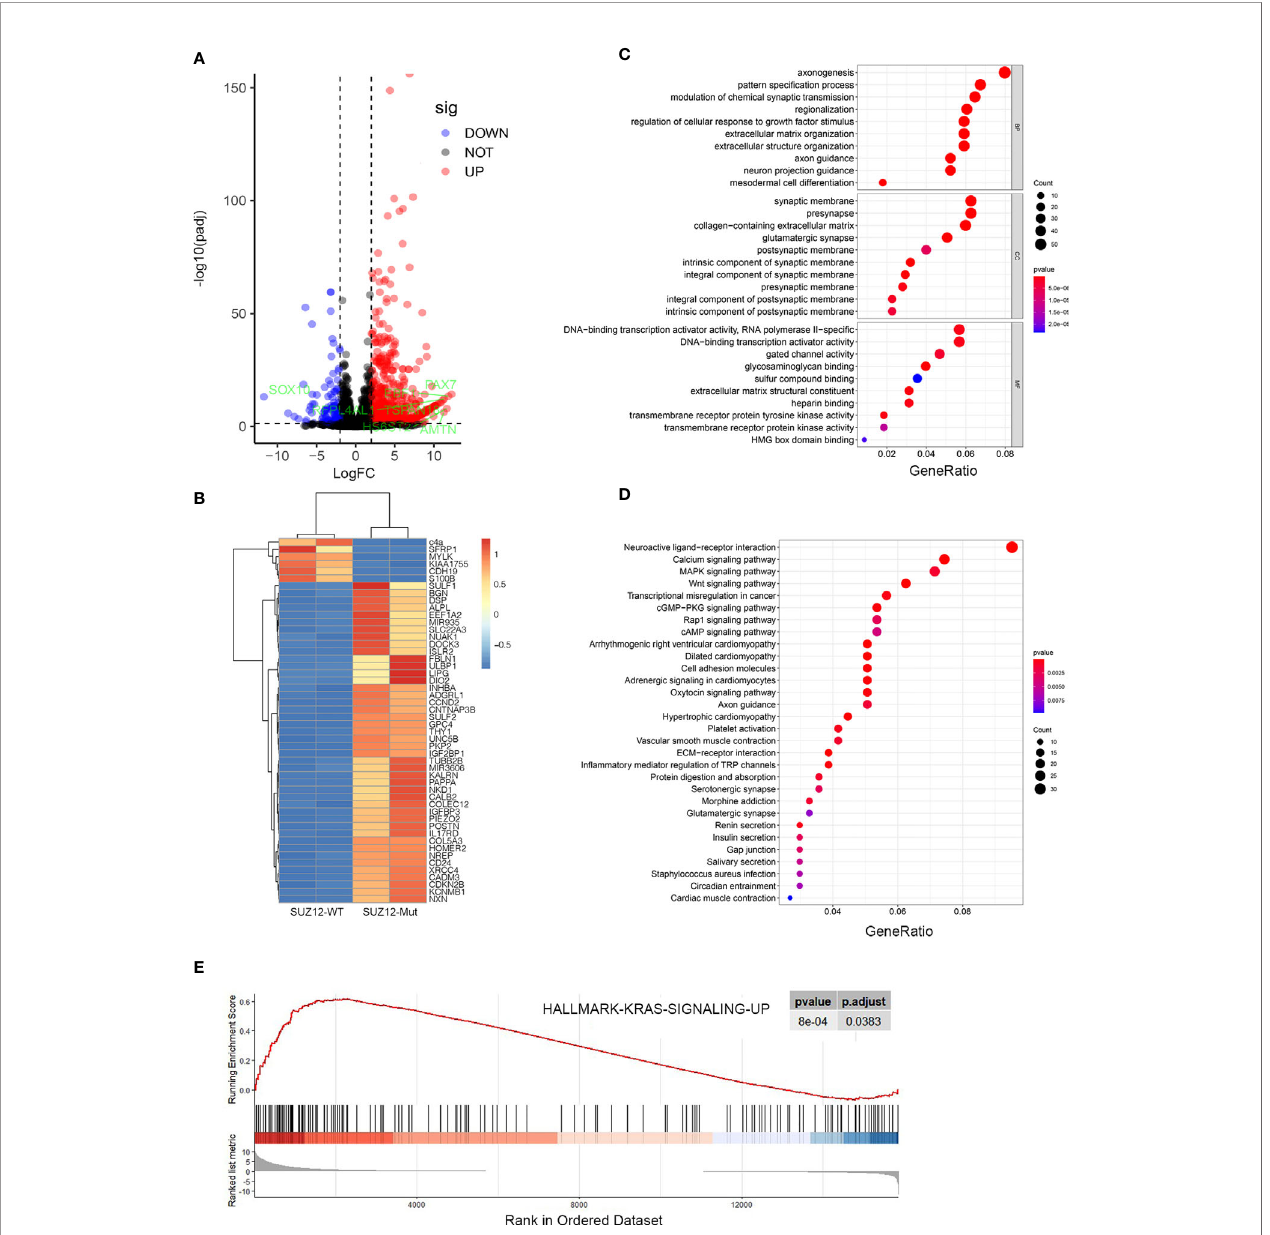
FIGURE 1 | Identi fi cation and enrichment analysis of the differentially expressed genes in GSE118186 data. (A) Volcano maps of DEGs in the dataset was showed by using p adj ≤ 0.05 and Log|FC| ≥ 2 as cut-off criteria. (B) Heatmap of top 50 differentially expressed genes in the dataset. (C) Gene Ontology (GO) enrichment analysis for the DEGs. (D) KEGG pathway enrichment analysis for the DEGs. (E) GSEA analysis showing DEGs enriched in KRAS